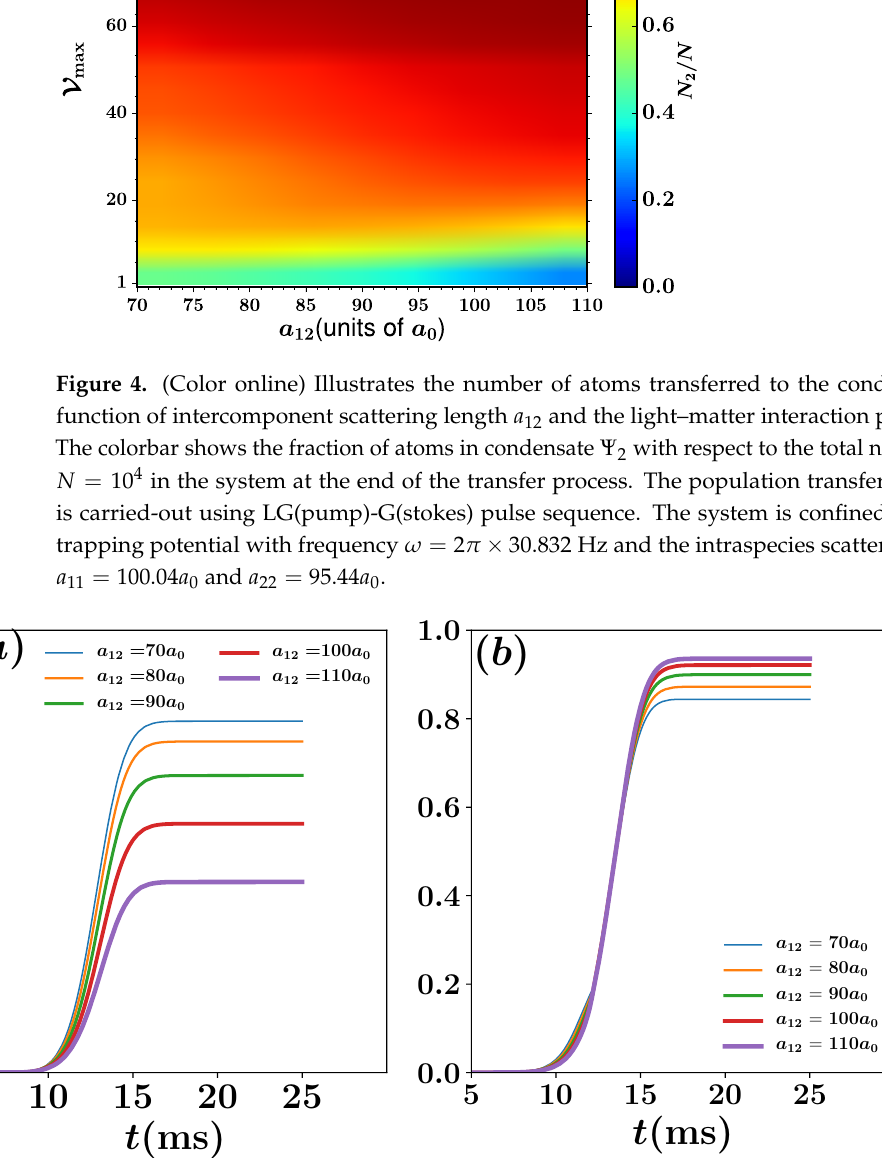
Figure 5. (Color online) Shows the time evolution of the population in the condensate Ψ 2 for a fixed Rabi frequency, with ( a ) V max = 1 and ( b ) V max = 10, and different interspecies scattering lengths a 12 [see legends]. The dynamics is triggered by employing LG(pump)-G(stokes) pulse sequence. The BEC Ψ 2 is confined in a harmonic trapping potential with frequency ω = 2 π × 30.832 Hz. The total number of atoms in the system is N = 10 4 and the intraspecies scattering lengths are given by a 11 = 100.04 a 0 and a 22 = 95.44 a 0 . For V max = 1, larger a 12 suppresses the population transfer processes, but favors the same for V max =